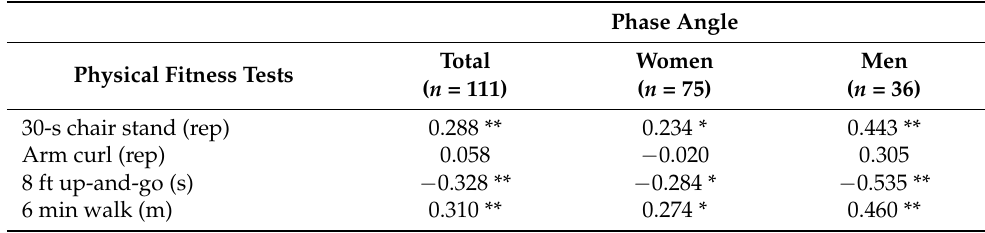
Table 3. Pearson’s correlation between phase angle and physical function for total, women and men.